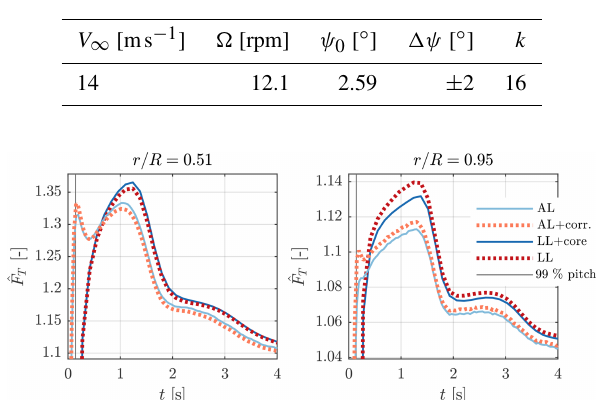
Figure 14. Normalized tangential force response at two blade sec- tions (middle and tip) of the NREL 5-MW following a pitch step of + 2 ◦ in 0.14s at 14ms − 1 predicted by AL simulations with/without smearing correction and LL with/without viscous core ( N s = 9, (cid:15) = 0 . 2 R ).